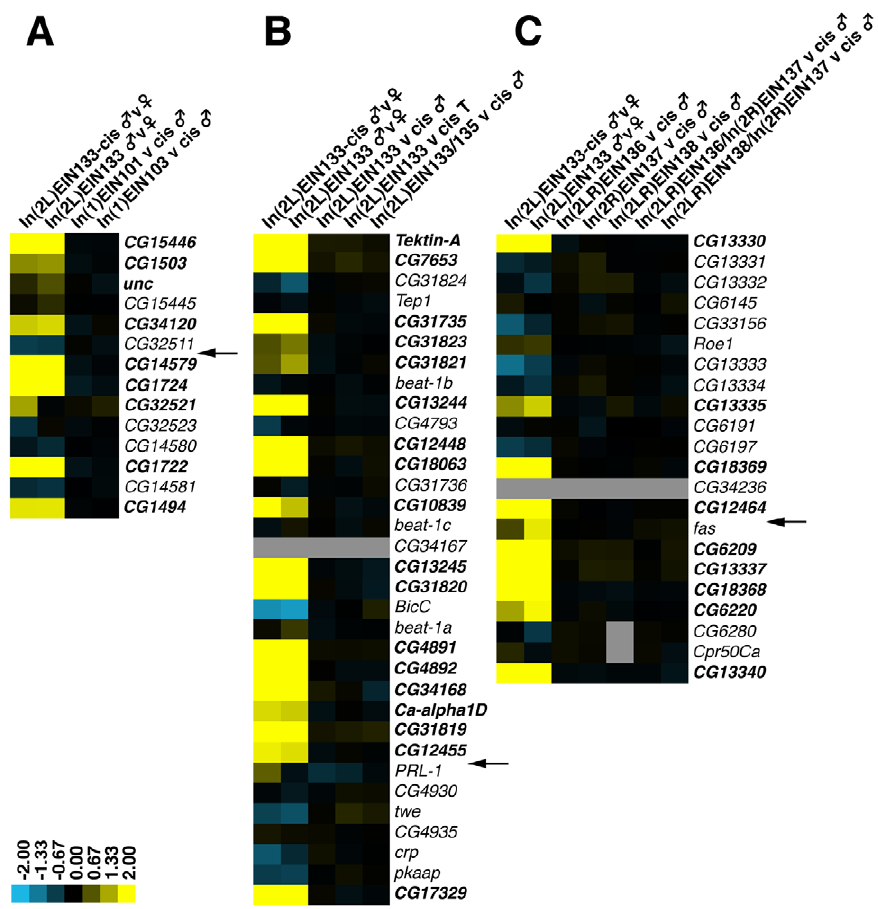
Figure 2. Microarray analysis of gene expression. (A) 19F, (B) 35F, and (C) 50B. For each neighbourhood the heatmaps display the average log2 expression ratio of each gene in the indicated comparisons according to the colour scale at the bottom. The location of the inversion breakpoint within each neighbourhood is indicated by the arrows. Data from the In(2L)EIN133 inversion and cis male versus female comparisons are shown for each neighbourhood. The ‘‘ cis ’’ designation is shorthand for the uninverted progenitor chromosome that carries the 2 RS insertions used to direct the recombination event. Grey regions indicate no data. While the male versus female comparisons show strong male biased expression (yellow), when inversion males are compared to their non-inversion progenitors there is very little change in expression (black). T, testis.